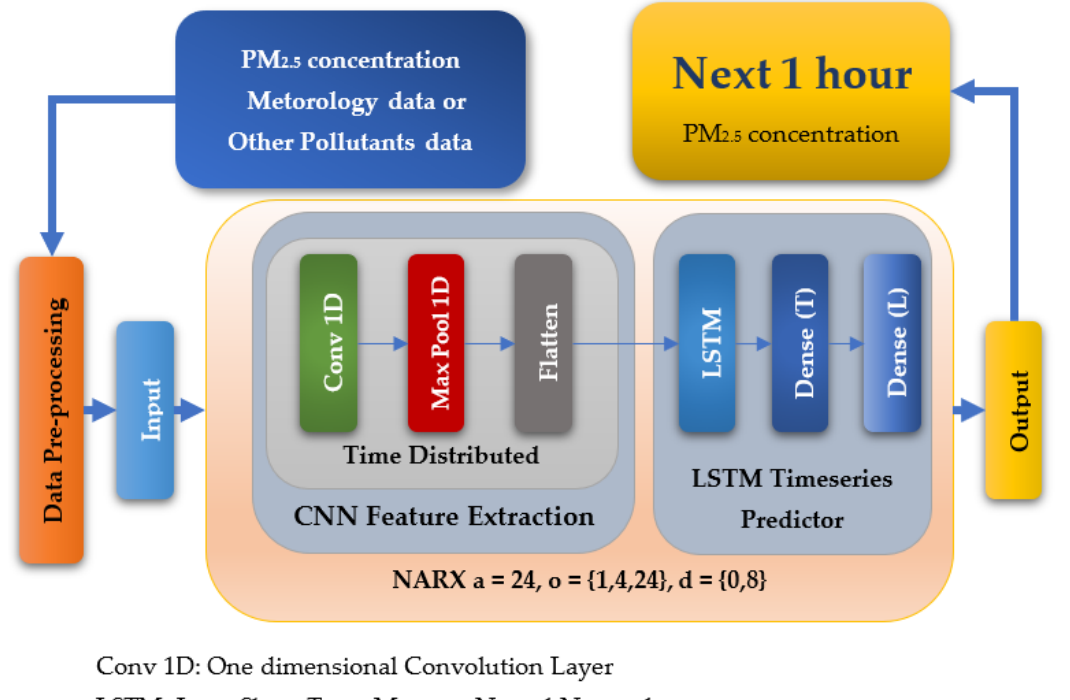
Figure 4. An overview of CNN–LSTM NARX proposed layers.